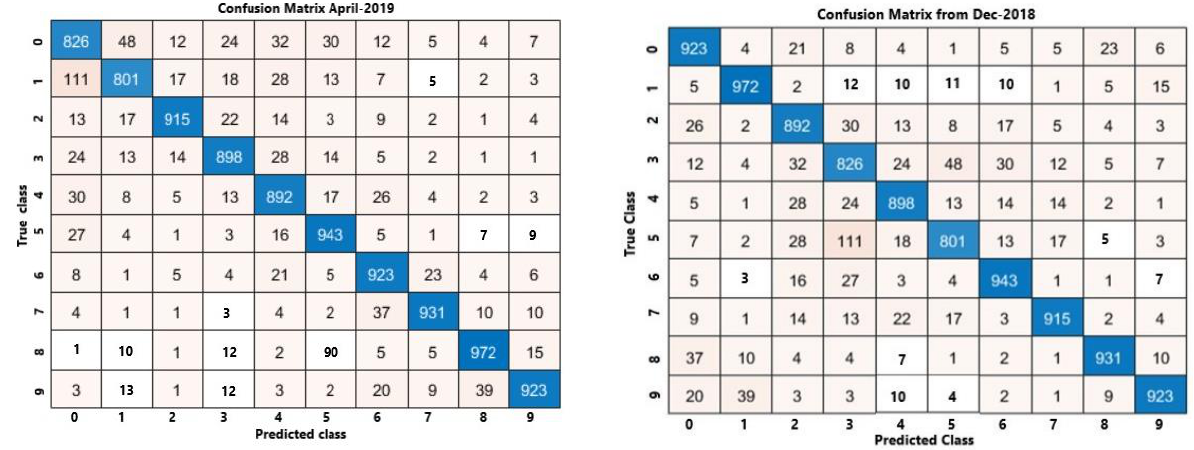
Figure 14. Confusion matrix metrics for April 2019 ( left ), and December 2018 ( right ).